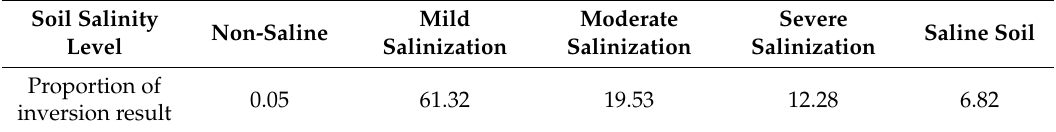
Table 4. Statistics of soil salinity grade area in wheat area (Unit: %).